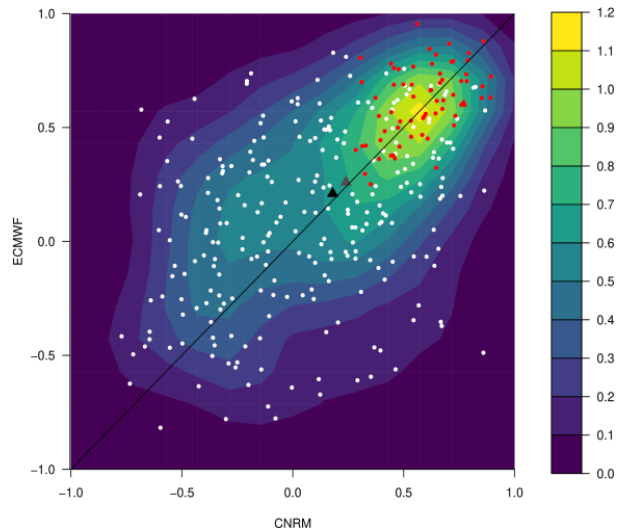
Figure 3. Scatterplot (dots) and probability density function (con- tours) of ECMWF ACC as a function of the corresponding CNRM ACC for each of the 320 wintertime reforecasts of EUR 2m tem- perature at week 3. Red dots mark ACCs significant at the 95% confidence level for both CNRM and ECMWF. The black and gray triangles correspond to the mean and the median point, respectively, and the solid black line to the y = x identity line.